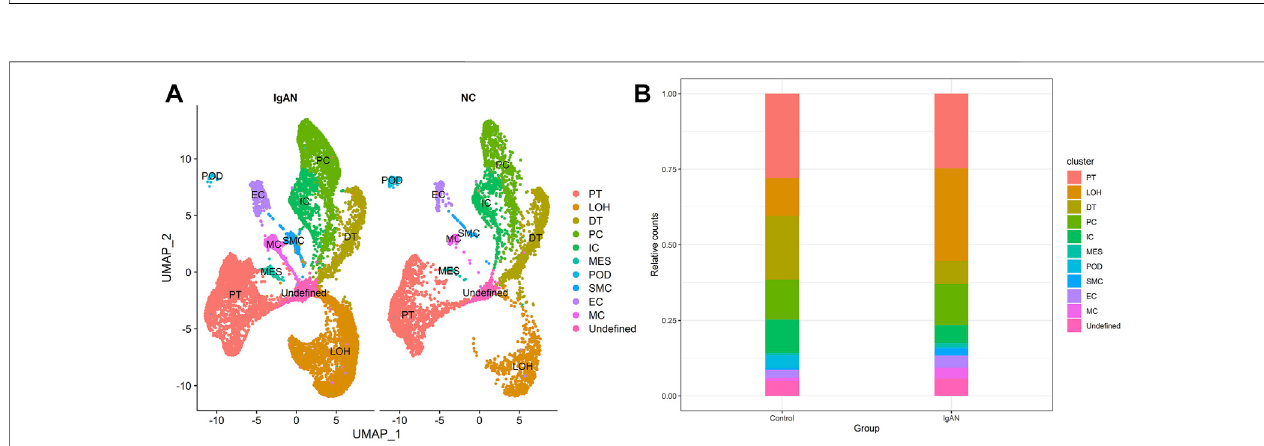
FIGURE 3 | Single-celllandscape of renal cells in IgAN and NC groups. (A) UMAP plots of IgAN and NC groups. (B) Bar chart visualization of cluster distribution in IgAN and NC groups.